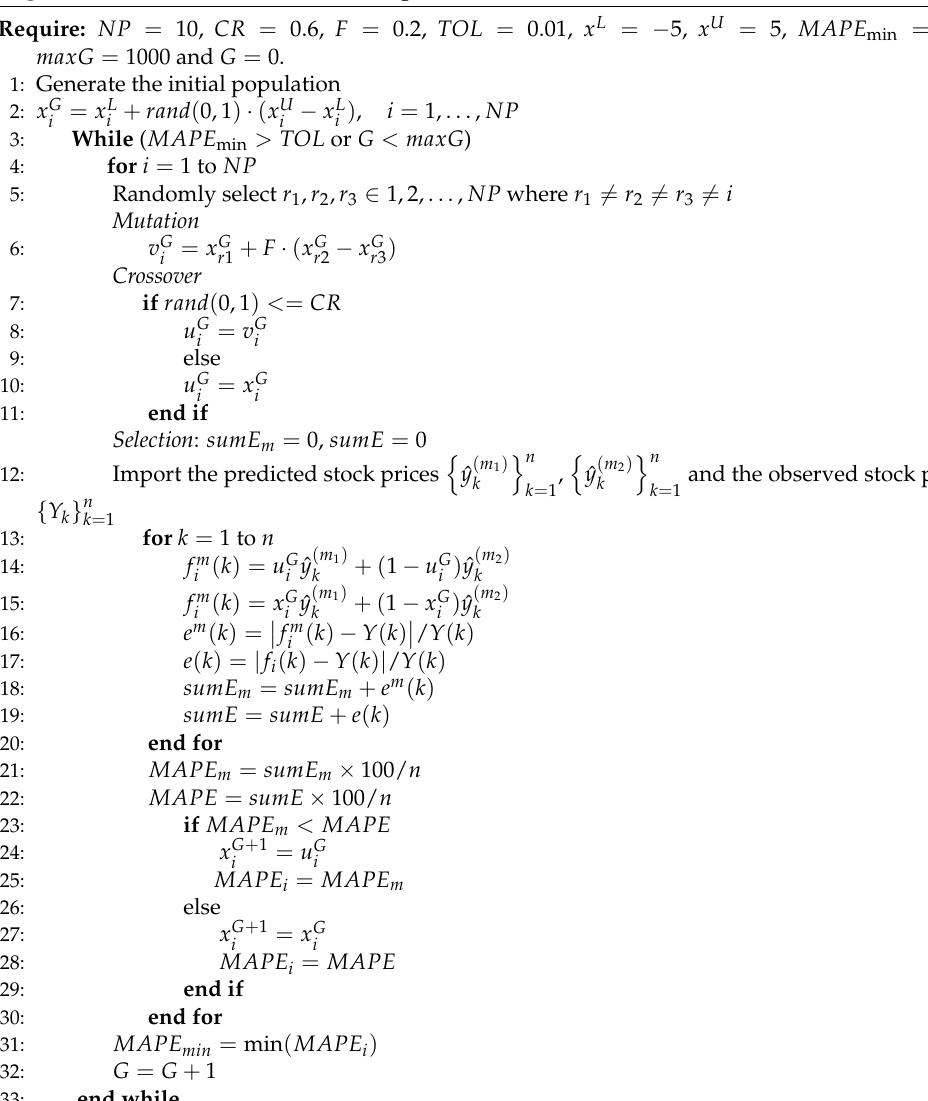
Algorithm 1 DE Pseudocode for weight